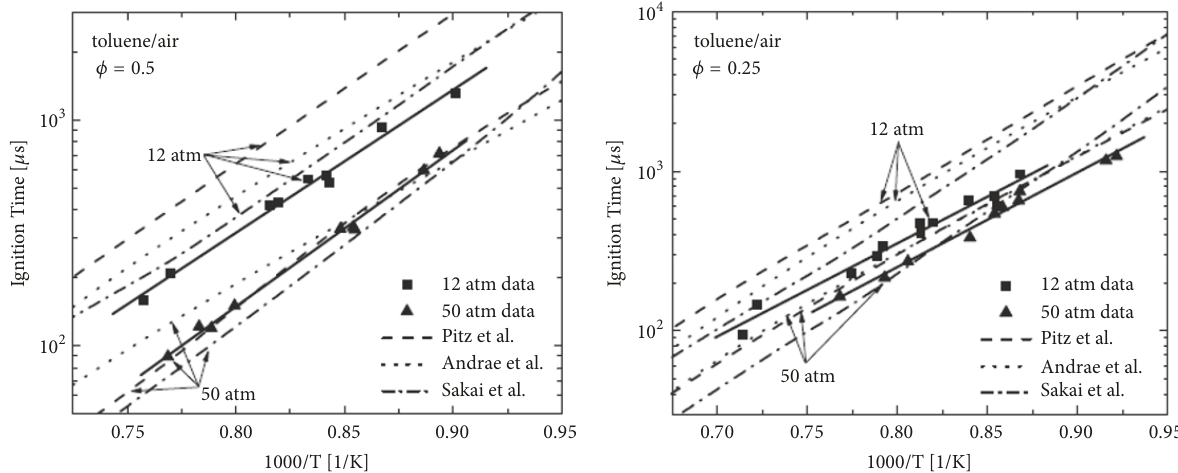
Figure 8: Ignition time measurements [27] for toluene/air mixtures at 12 and 50 atm at Φ = 0.5 comparing the predictions of three kinetic mechanisms, Pitz et al. [28], Andraeet al. [29], and Sakai et al. [30]. Ignition times were scaled to 12 and 50 atm to accountfor slightdeviations in reflected shock pressure by P −0.50 as determined by regression analysis. Figure is adopted from Shen et al. [27].